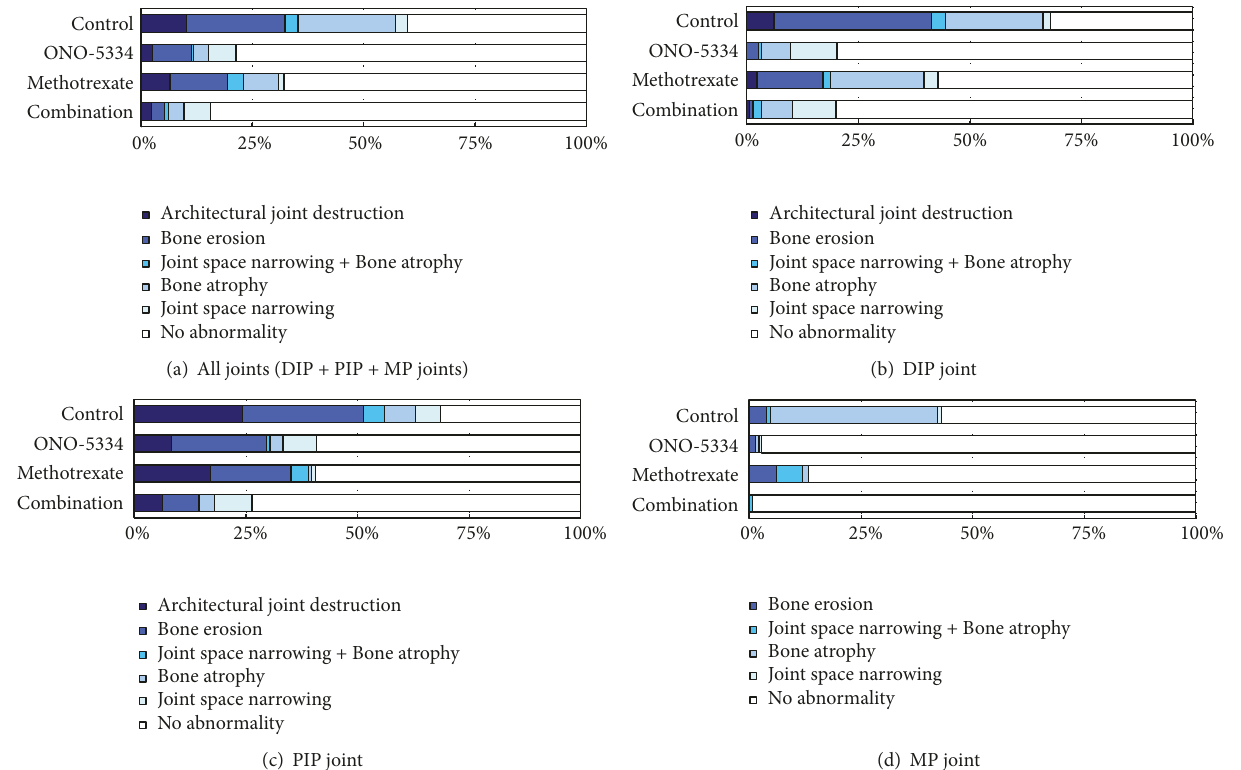
Figure 3: Severity of joint destruction at (a) all, (b) DIP, (c) PIP, and (d) MP joints in collagen-induced arthritis monkeys. The number of all joints (DIP + PIP + MP) was 384 (48 joints/monkey, n=8) in the control and MTX group and 432 (48 joints/monkey, n=9) in the ONO-5334 and ONO-5334/MTX